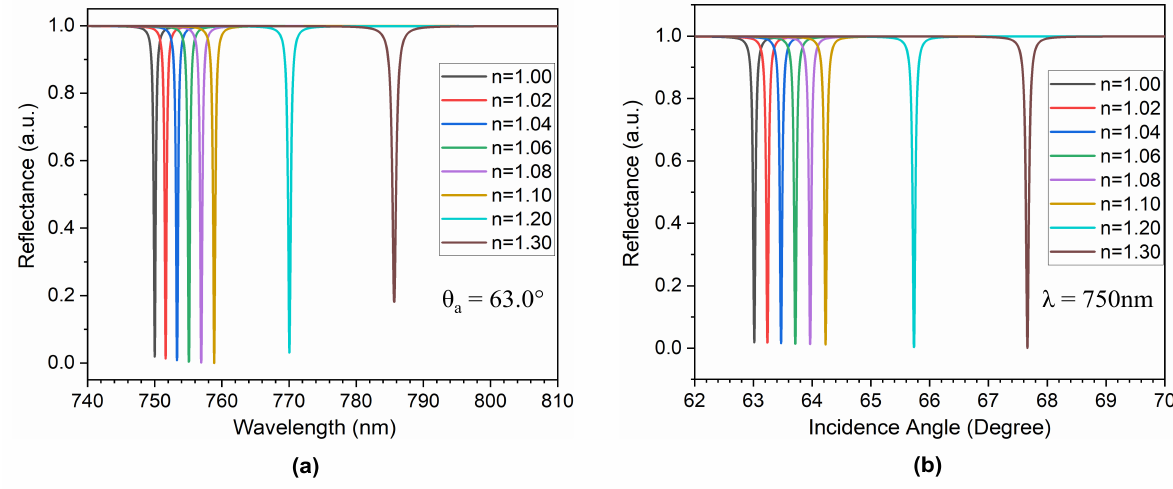
Figure 5. Sensitivity analysis of the n = 6 QPhC structure: ( a ) wavelength interrogation method and, ( b ) angular interrogation